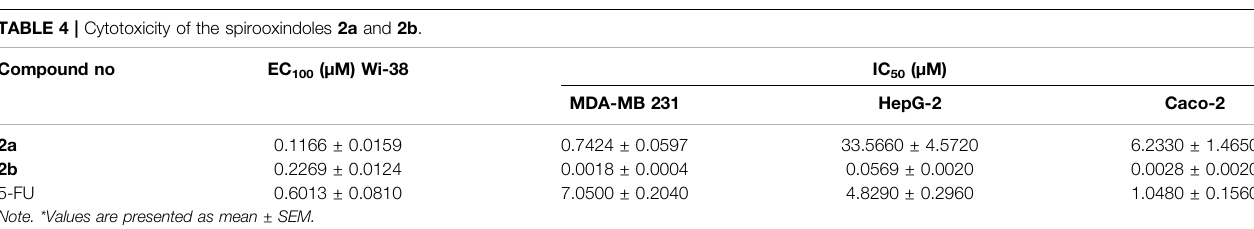
Frontiers in Chemistry |